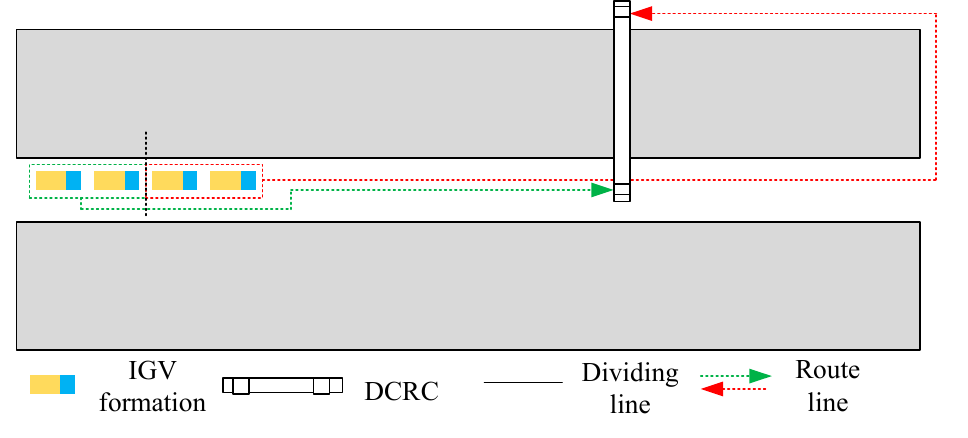
Figure 6. IGV formation dispersion strategy.